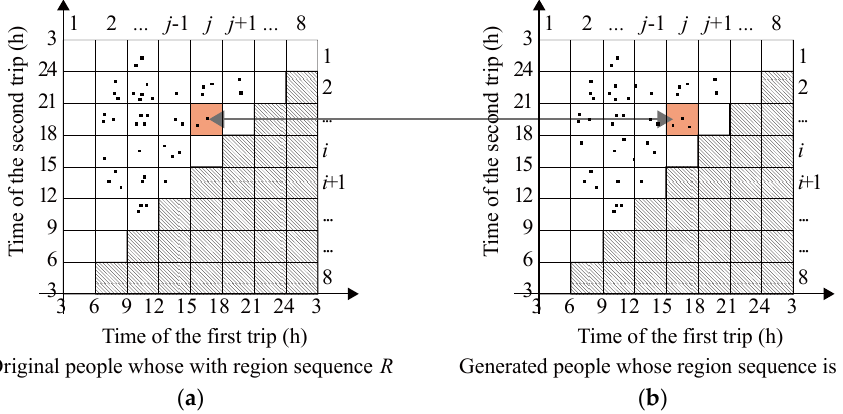
Figure 11. Method of plotting and cutting. ( a ) An example for people in the original dataset whose mobility sequences belong to region sequence 𝑅 ; ( b ) An example for people in the generated dataset whose mobility sequences belong to region sequence 𝑅 . After plotting, we compare the counts of people in each cell.